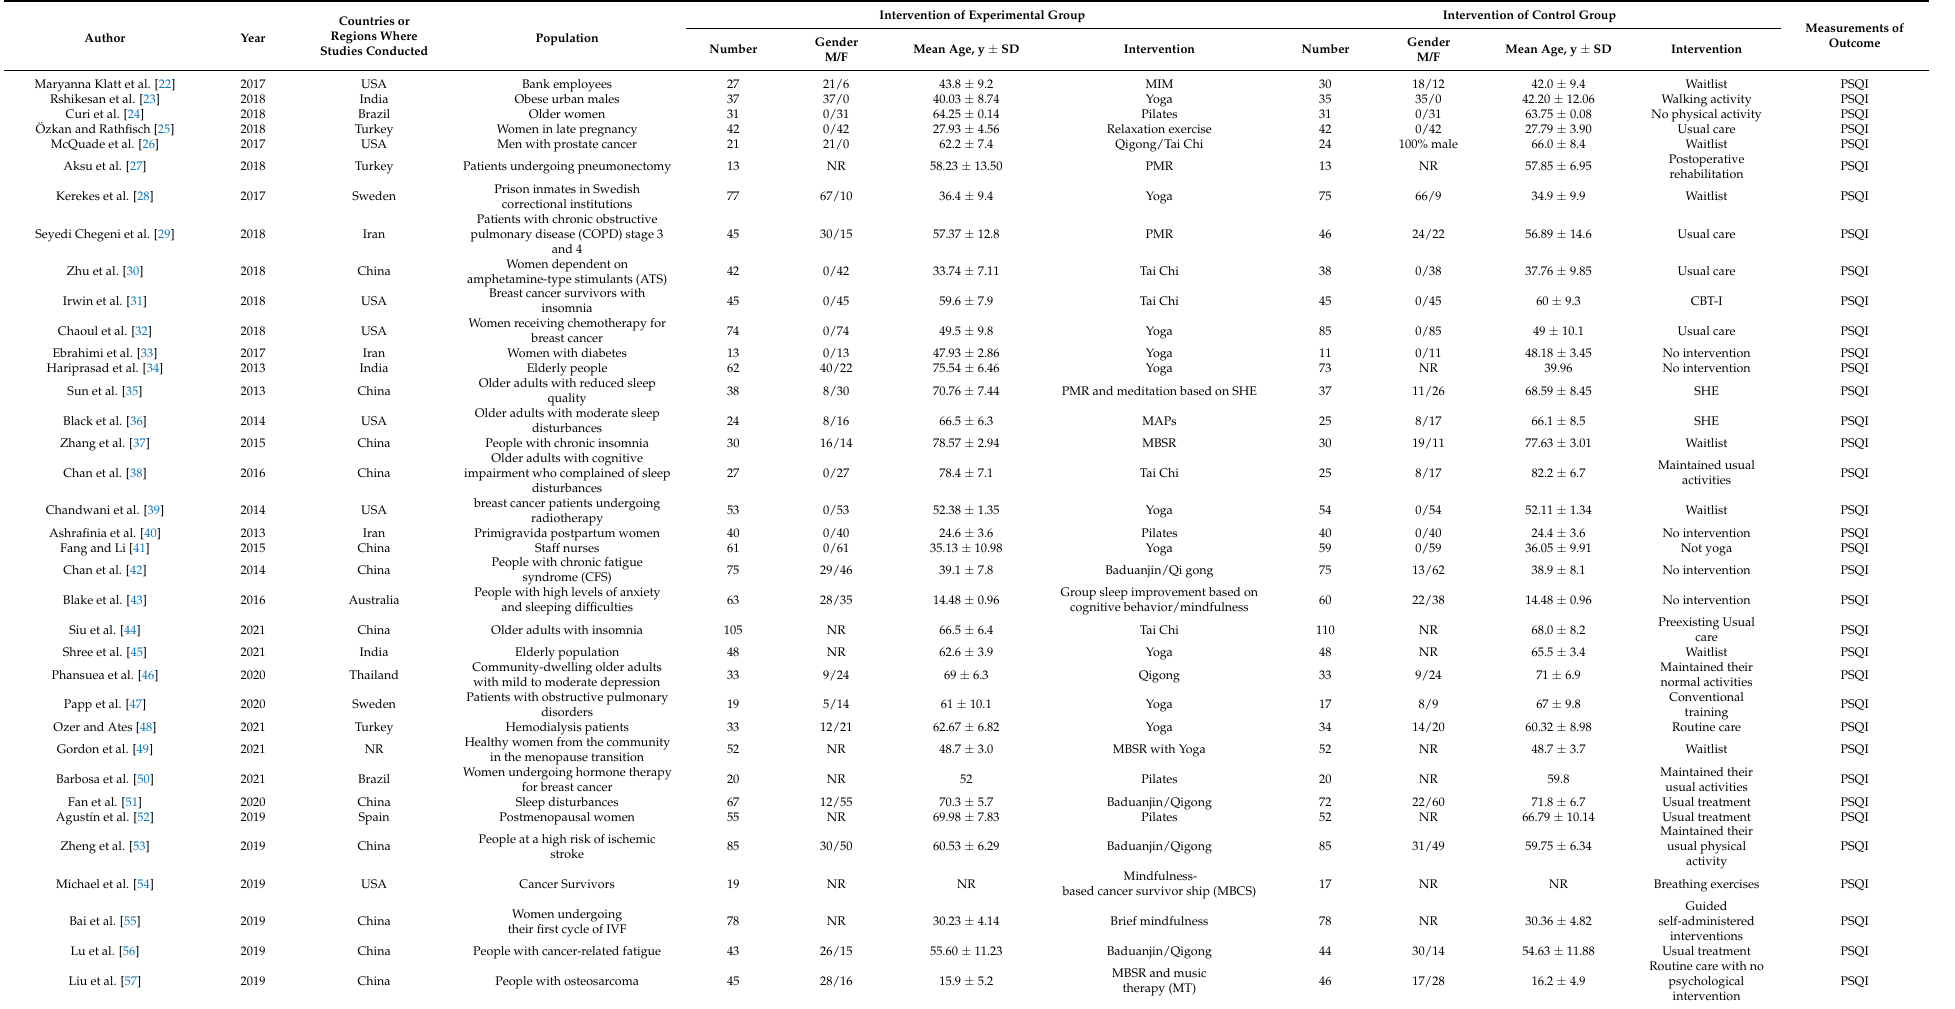
Table A1. Characteristics of all randomized controlled